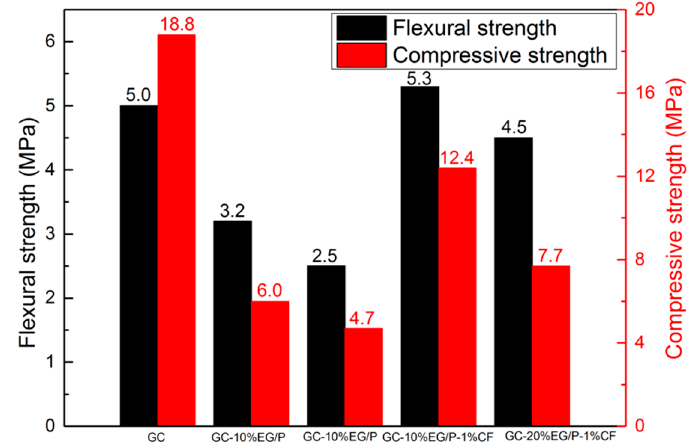
Figure 10. The mechanical strength of EGPG after seven days curing time.